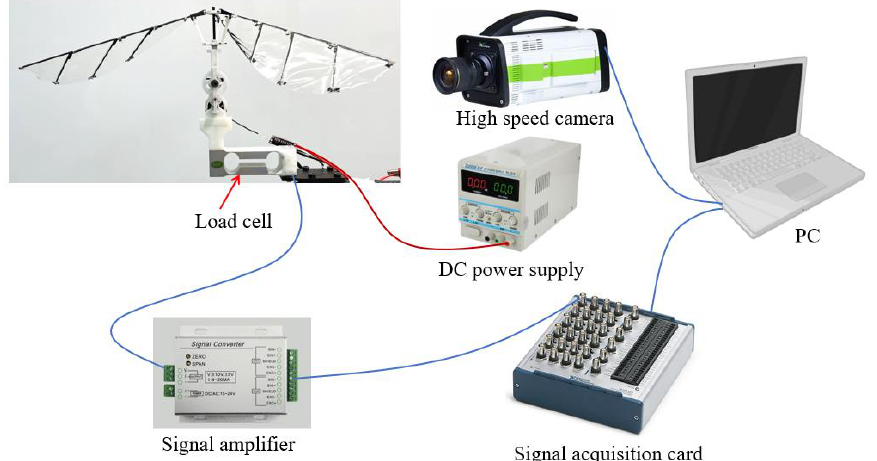
Figure 9. The flapping wing rotor experimental system.